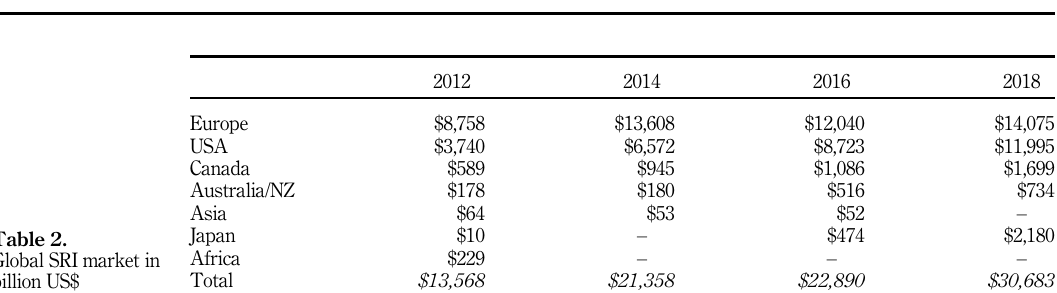
Table 1. Different uses of SRI term among organizations